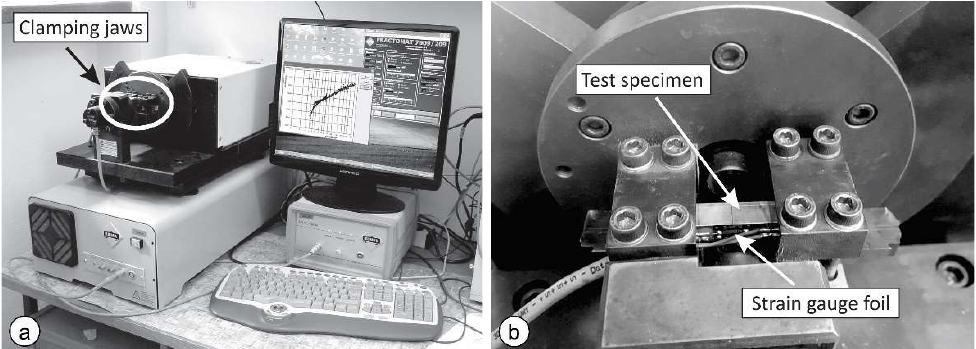
Figure 4. ( a ) The RUMUL Cracktronic and Fractomat machine; ( b ) specimen in the clamping jaws.